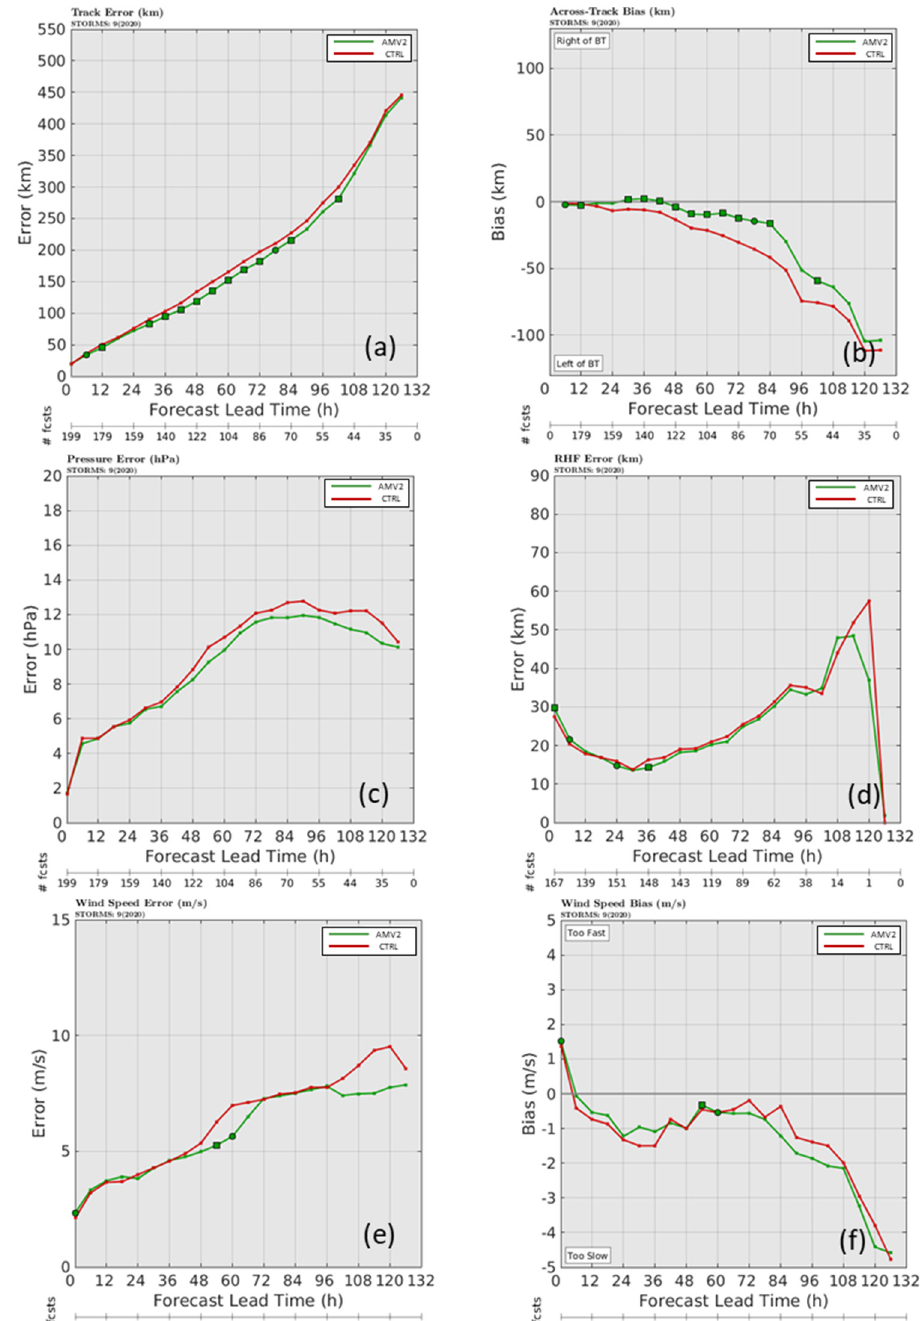
Figure 13. Verification statistics for the 2020 hurricane seasons in the Eastern Pacific Ocean for control (red) and experiment AMV2 (green). AMV assimilates hourly SWIR and VIS as well as high-temporal AMVs for all five wind types. It also uses the new QCs and error profiles. Panel ( a ) is track error [km], ( b ) is cross track bias [km], ( c ) is minimum central pressure [hPa], ( d ) radius of hurricane-force (RHF) wind error [km], ( e ) is intensity error measured using maximum sustained 10 m winds [m/s] and ( f ) is intensity bias [m/s]. Squares (circles) indicate statistical significance at the 95% (90%) confidence level based on a paired t -test with adaptive serial correlation. The number of samples used in deriving these statistics is shown in the secondary axis.